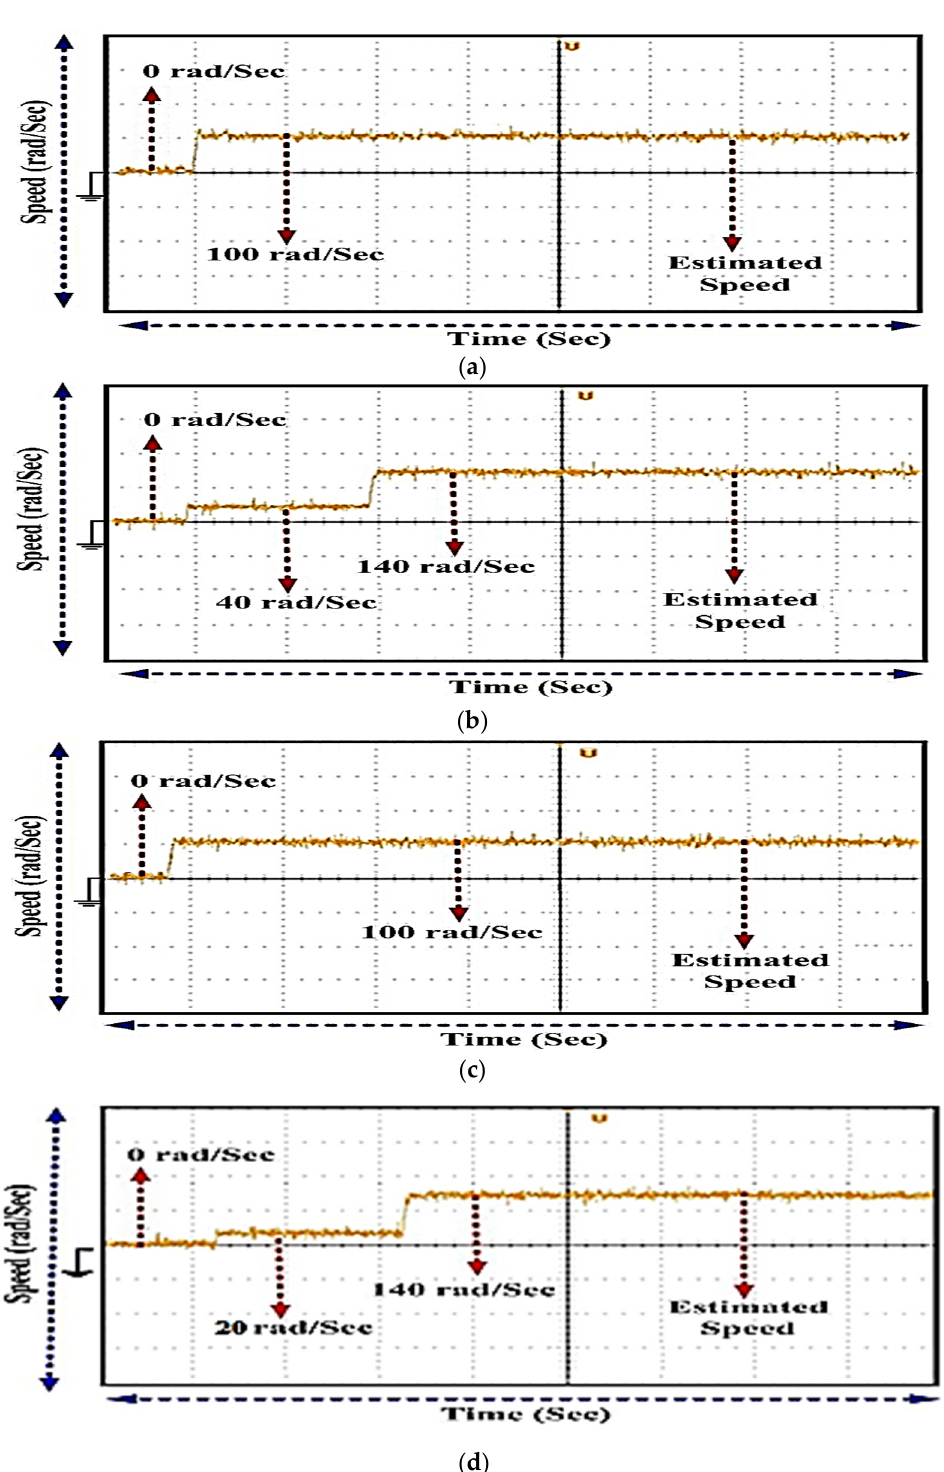
Figure 16. Estimated speed: ( a ) for a constant speed reference of 100 rad/sec for SMLO1, ( b ) for a step speed reference of 40–140 rad/sec for SMLO1, ( c ) for a constant speed reference of 100 rad/sec for SMLO2 and ( d ) for a step speed reference of 20–140 rad/sec for SMLO2. The poles of SMLO2 were shifted to the left of SMLO1 as shown in Figure 17 indicating improved stability performance. The effect of this was more predominant in the low speed regions where the SMLO2 was able to track speeds around 20 rad/s as compared to SMLO1, which is unable to track speeds of the same range. The poles being shifted more to the left of SMLO1 had led to increased speed bandwidth of SMLO2. Owing to high rating of the motor, the dynamics of the stator current impacted the performance of the observer and as a result, the pulsations in the disturbance torque could be attributed to the same. For hysteresis regulation, it is difficult to predict the exact switching frequency since it is not related to the hysteresis band. The OP45OO target provides a maximum switching frequency of (1/(2 × time step)), i.e., 10 kHz. Owing to successful execution of the model, it is to be understood that the switching frequency was within the 10 kHz range. Driving an EV is an endless series of dynamically changing operating states corresponding to the actual driving trajectory and speed of the vehicle, however, the analysis confines itself to low and medium speeds in the motoring mode and for constant load torque of 100 Nm (for all cases except Section 5.2, where there is a step load perturbation). Table 2 highlights the improved dynamic performance of the proposed observer for the different parameters. Figure 17. Pole placement of SMLO1 and SMLO2.